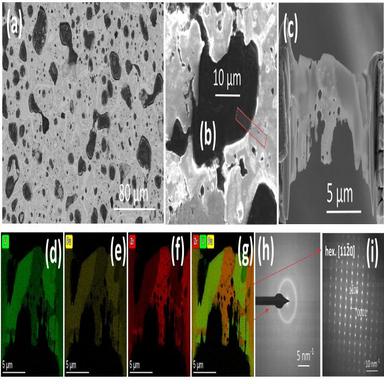
Fuel center region contains pores with a bimodal size distribution. The larger pores are tens of μm while smaller pores are less than 1 μm (a); A TEM sample was extracted at a site across the fuel center matrix and pore (red box in b); FIB thinning revealed the dual phases matrix with different porosity (c); STEM EDS (d-f) of U, Pu, and Zr shows the relatively porous phase is Zr rich while the dense phase is U + Pu rich (g); SAED pattern shows the dense phase has amorphous features (h); while the porous pha